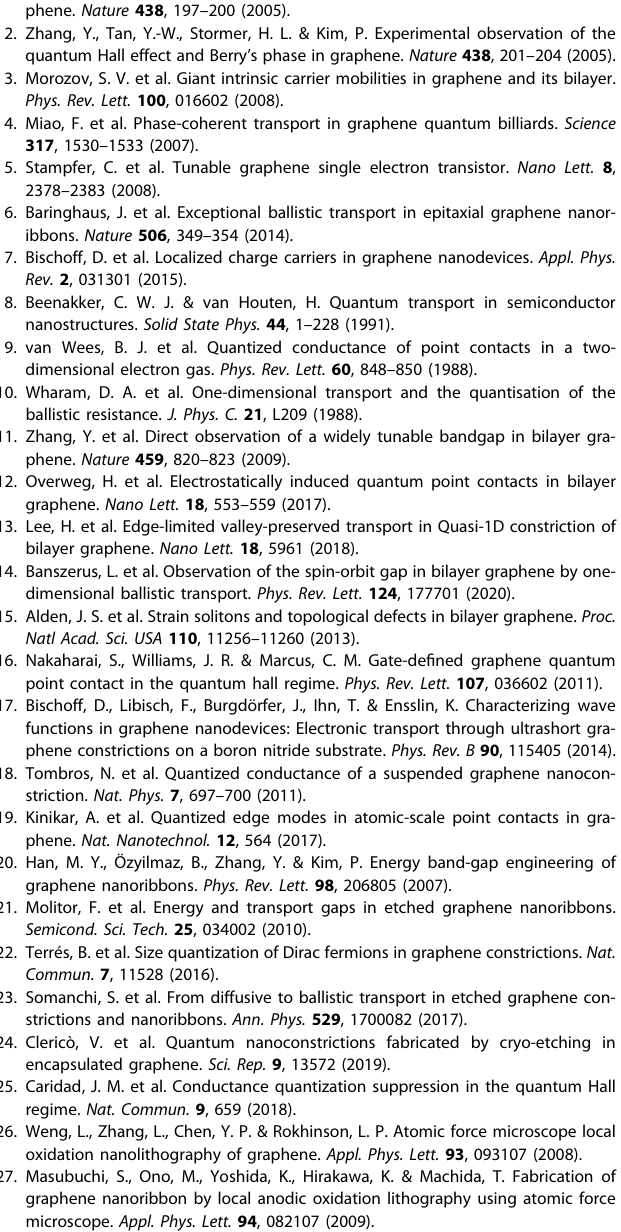
Fig. 4 Temperature dependence of QPC characteristics for a ~60 nm wide constriction cut along zigzag direction. For clarity the curves are successively offset by 2 e 2 / h (from blue to